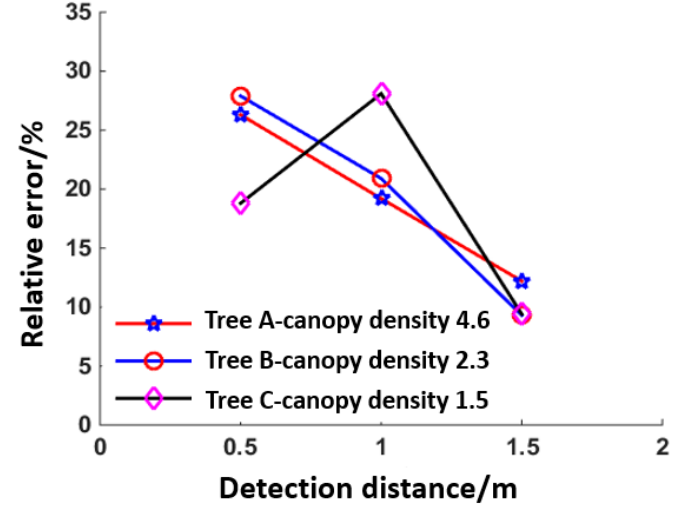
Figure 12. Relative error curve of canopy thickness detection results at different detection distances.